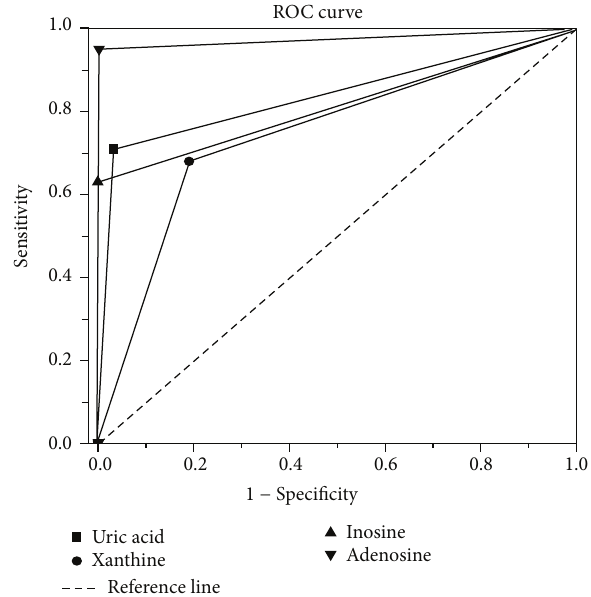
Figure 4: ROC curves of uric acid, xanthine, inosine, and adenosine in groups DM and DR. Adenosine shows more sensitivity and specificity for diabetic retinopathy diagnosis than other potential